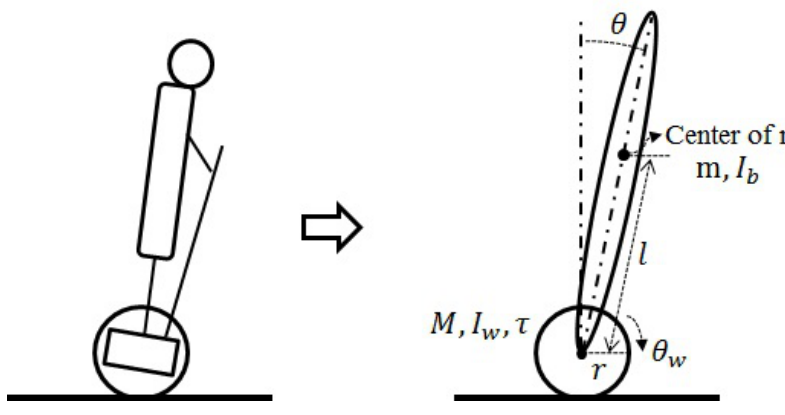
Figure 1. Segway model